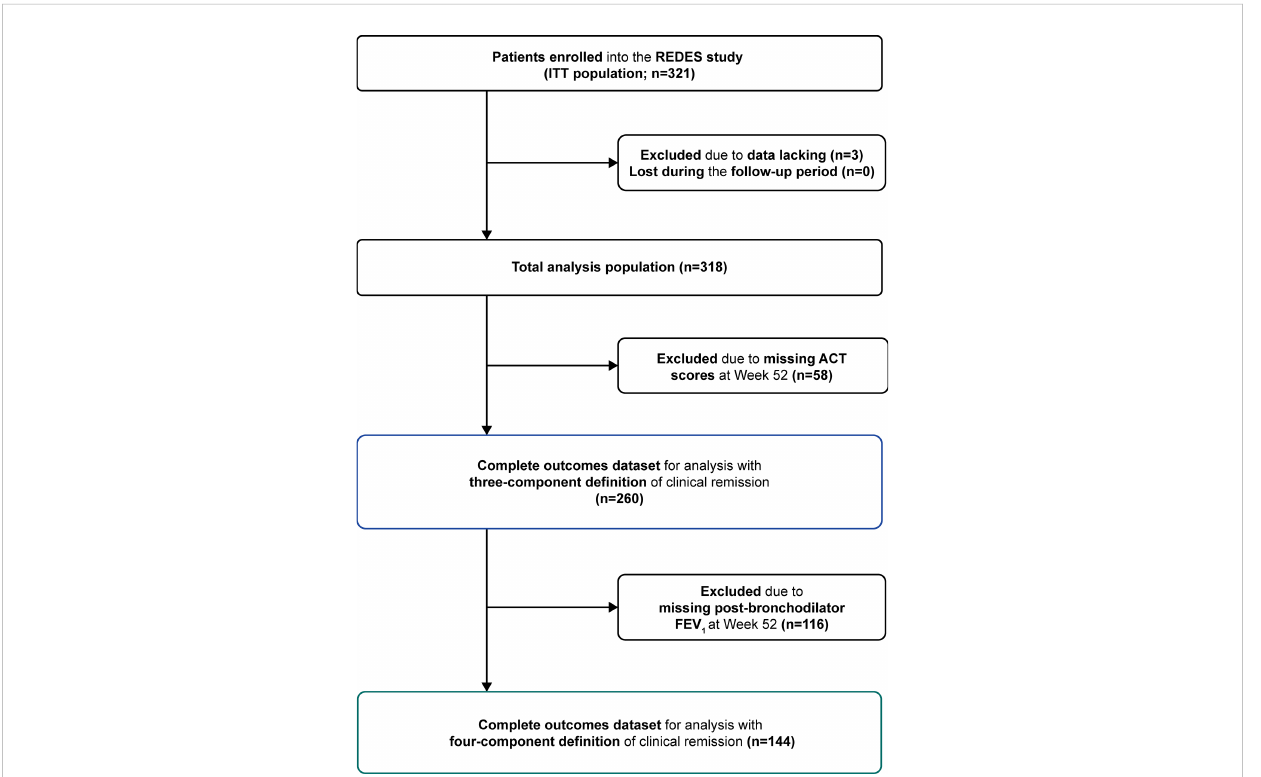
FIGURE 2 Patient attrition and outcome datasets for analysis. ACT, Asthma Control Test; FEV 1 , forced expiratory volume in 1 second; ITT, intention-to-treat; REDES, REal worlD Effectiveness and Safety of